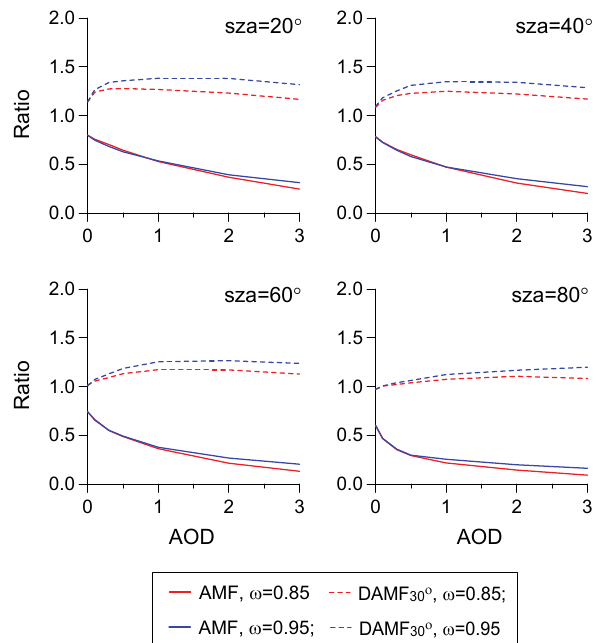
Fig. 17. Changes in the ratio of the simulated AMFs for elevated aerosol layers (an NO 2 profile of 0–200m and an aerosol profile of 0–1km) to the AMFs used in the standard satellite retrieval (the std95 profile for the SCIAMACHY retrieval) (solid lines), as well as the ratio of the simulated DAMF 30 ◦ , trop for elevated aerosol layers to the geometric approximation used in the ground-based MAX- DOAS retrieval (dashed lines), as functions of aerosol optical depth (AOD) for single scattering albedos ( ω) of 0.85 (red lines) and 0.95 (blue lines) and for different solar zenith angles (SZA), respectively.